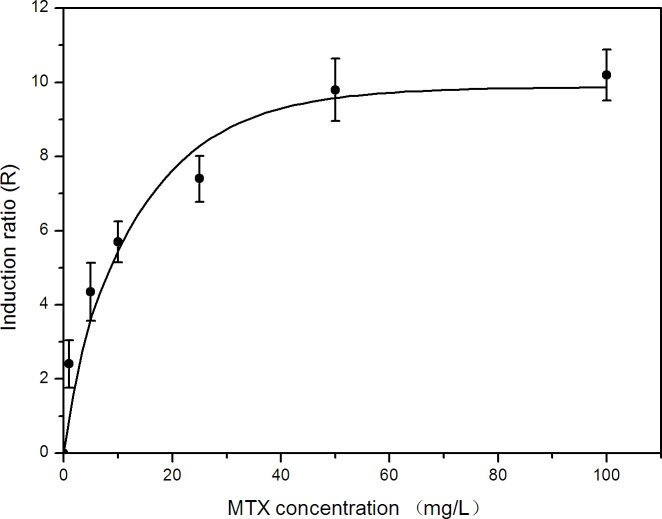
Effects of methotrexate dose on umu gene expression in S. typhimurium TA1535/pSK1002.